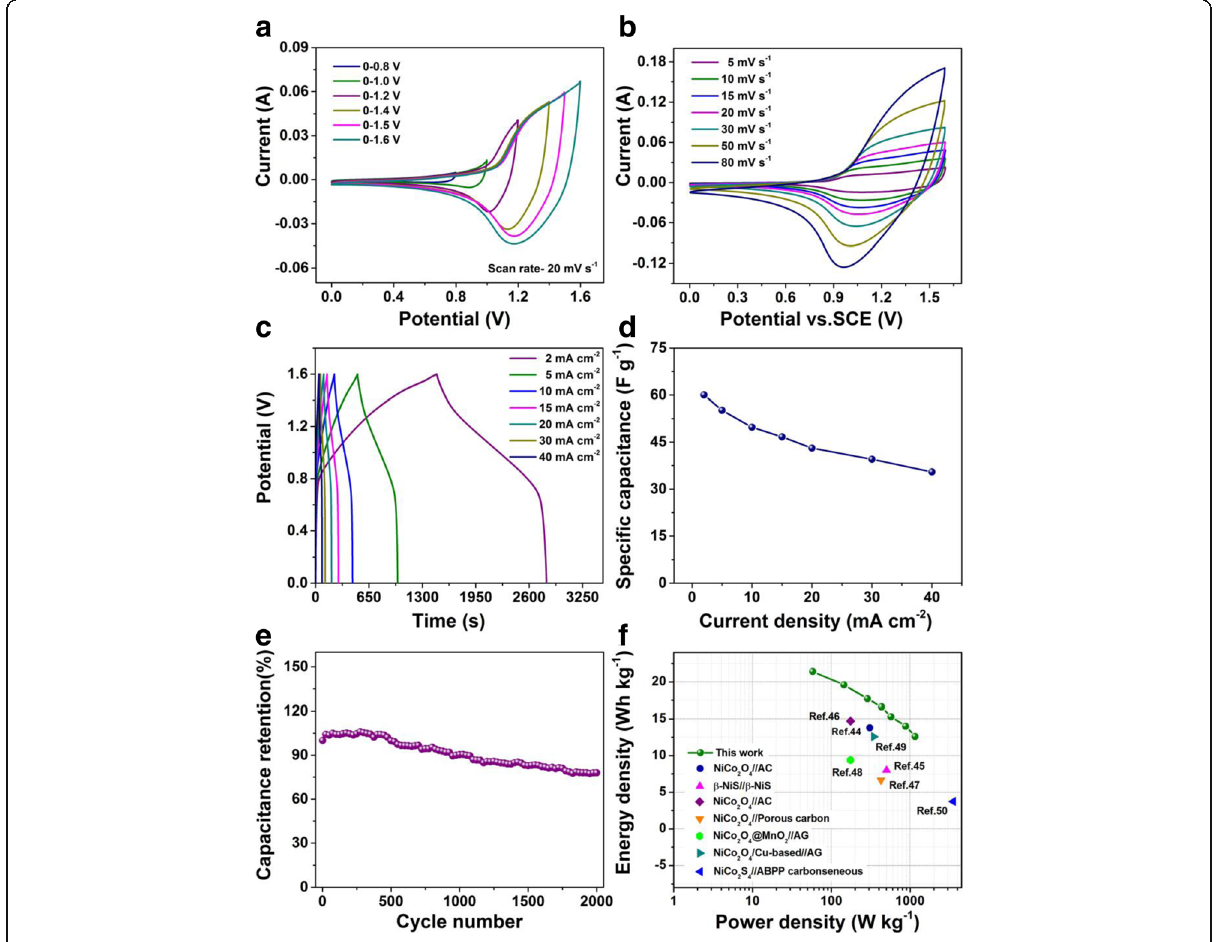
Fig. 5 a CV curves of NiCo 2 S 4 @NiMoO 4 //AC asymmetric supercapacitor collected in different voltage windows at 20 mV s -1 . b CV curves of